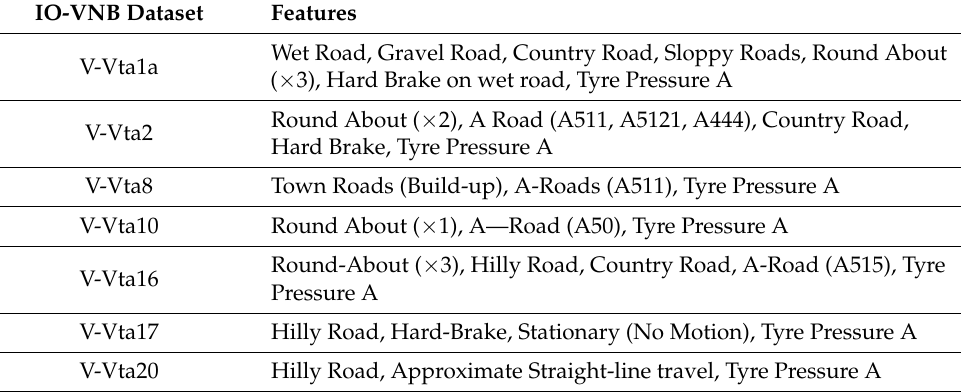
Figure 3. Data collection vehicle, showing sensor locations [2]. Table 1. Inertia and Odometry Vehicle Navigation (IO-VNB) data subsets used for the model training